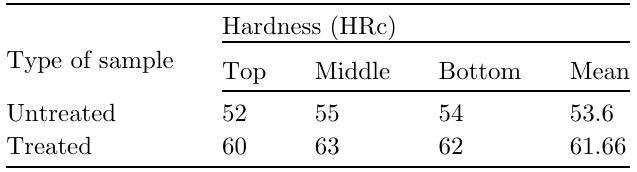
Table 3. Experimental data obtained during hardness